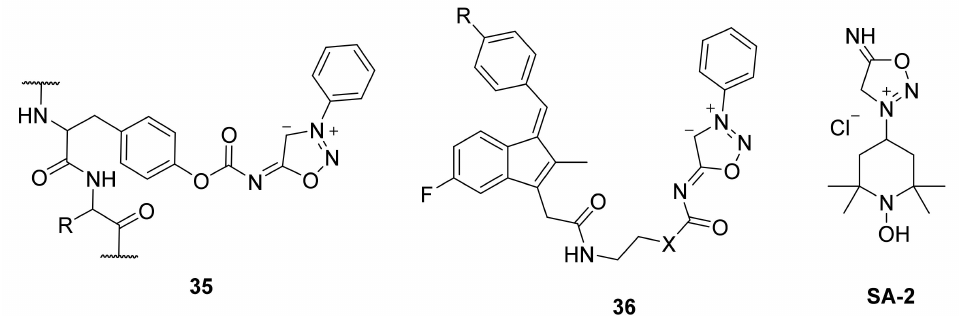
Figure 3. Structures of sydnone imine-based hybrids.